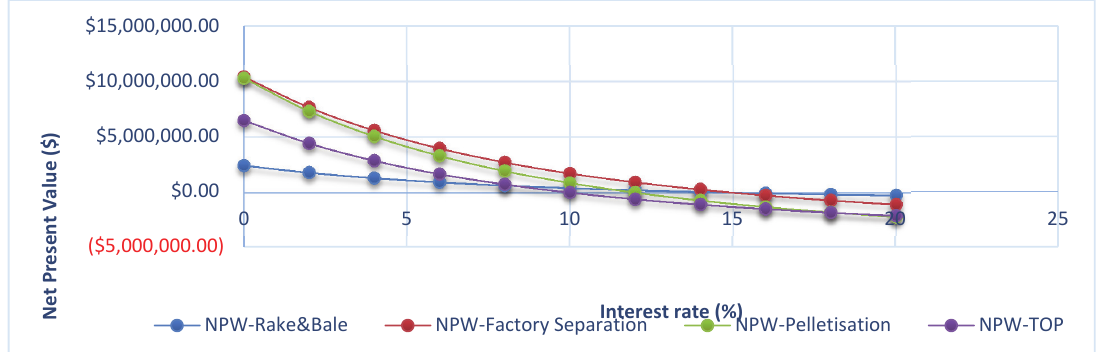
Fig. 12. Net Present Worth (NPW) - Cane factory separation, Rake and Bale Recovery, Pelletisation and TOP Energy Densification